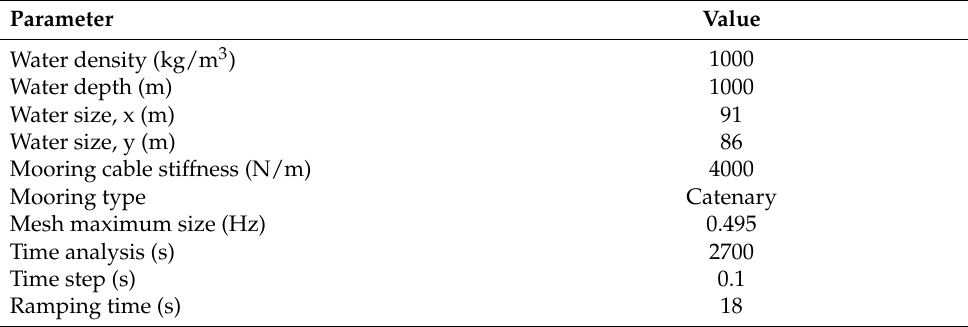
Table 2. Some inputs used in the Ansys AQWA simulations.